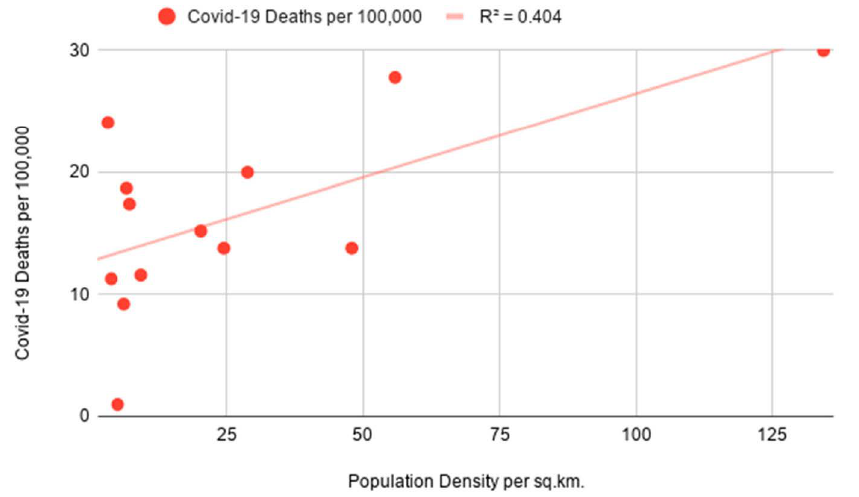
Figure 6. Simple linear regression with population density as an independent variable and Covid-19 deaths as a dependent variable for Saudi Arabia’s administrative